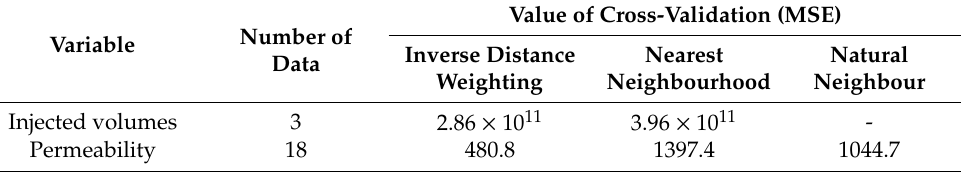
Table 1. Summary results of cross-validation (mean square error, MSE) for IDW, NN, NaN and modified Shepard’s method (MSM) methods [41].